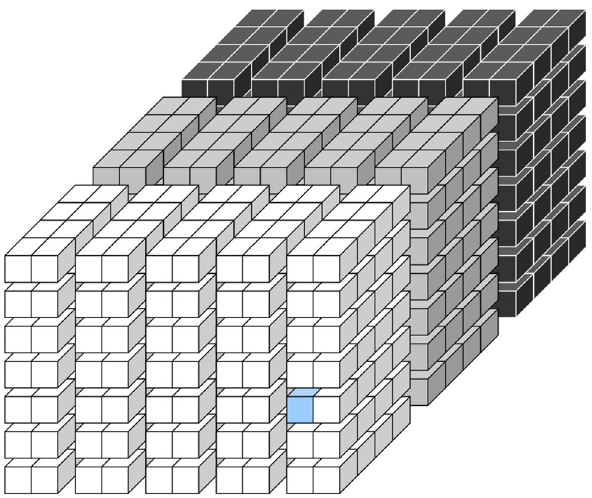
Fig. 1 Drawing of the detector, represented in bluish, embedded in the LVD experiment, southern